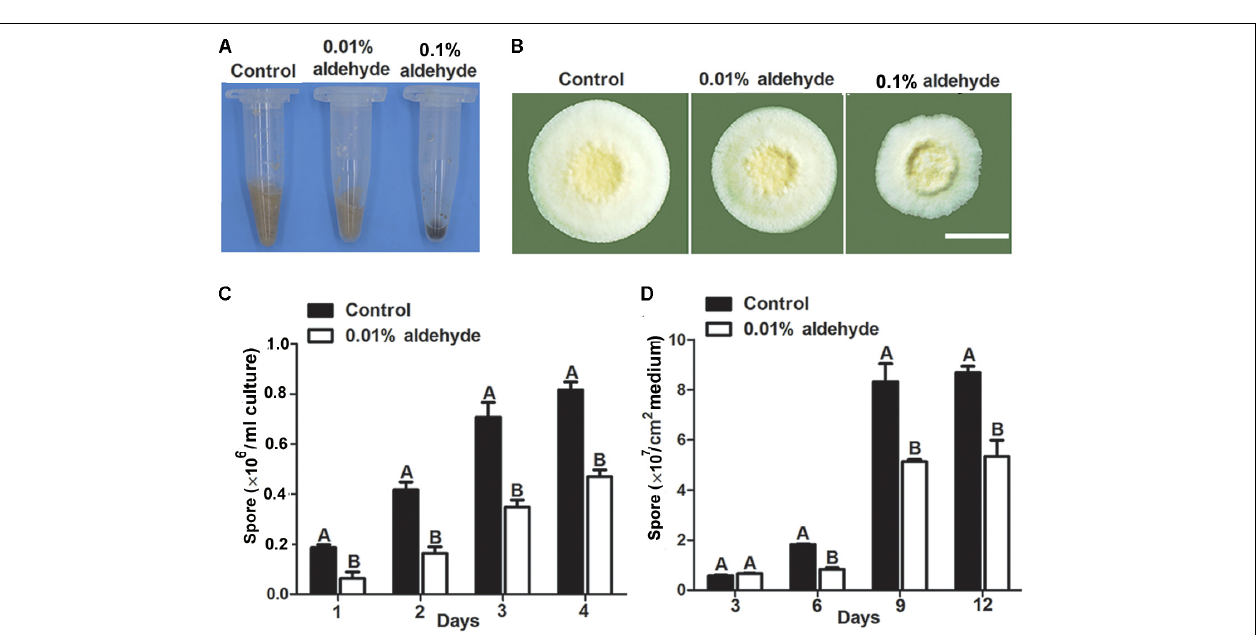
FIGURE 5 | Alcohol and acetaldehyde production under low oxygen condition. Concentration of alcohol (A) and acetaldehyde (B) in liquid medium at the different cultural time. Error bars are standard deviations of three trials.